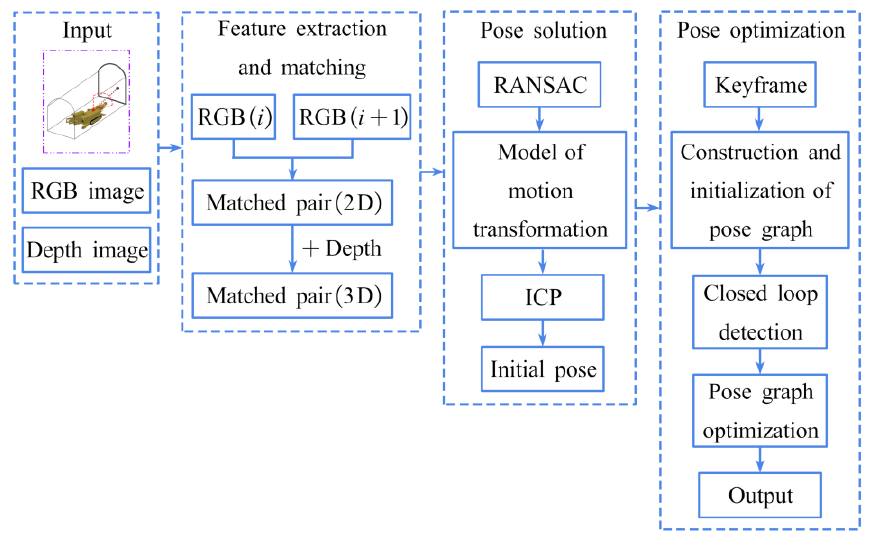
Figure 4. Vision-based pose estimation scheme of roadheader.